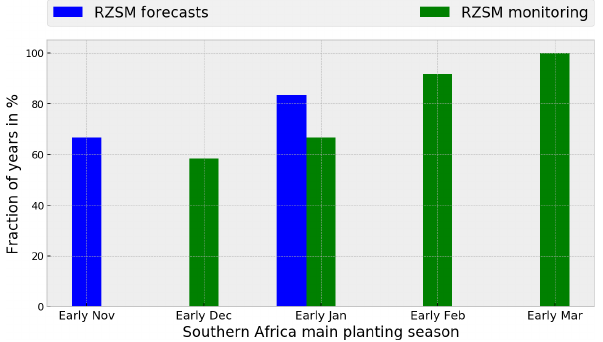
Figure 7. Fraction of years with below-normal regional crop yield (based on the rank of detrended crop yield) given that the corre- sponding RZSM forecasts (initialized on 1 November and 1 Jan- uary) and RZSM monitoring product (available in early March) were in the lowest tercile (based on the rank of the RZSM cli- matology). Note that the 1 November (1 January) RZSM forecast- based probability of ∼ 66% ( ∼ 83%) is statistically significant at the ∼ 86% ( ∼ 95%) confidence